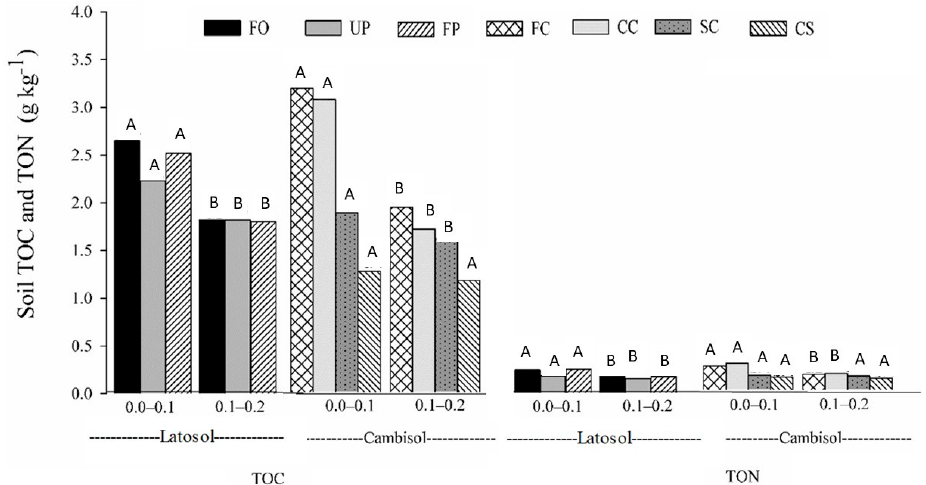
Figure 2. Total organic carbon (TOC, g kg − 1 ) and organic nitrogen (TON, g kg − 1 ) for latosol (forest-FO, unfertilized pasture-UP, fertilized pasture-FP) and cambisol (forest-FC, coast cross-CC, sugarcane- SC, and corn silage-CS) for the surface (0.0–0.1 m) and subsurface (0.1–0.2 m) layer. Within each soil type/land use combination, bars with different upper-case letters are significantly different ( p < 0.05) between surface and subsurface layers.